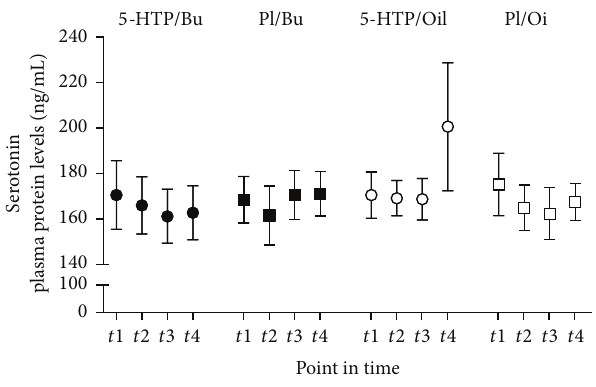
Figure 2: Serotonin plasma levels. The influence of 5-hydrox- ytryptophan (5-HTP) and fatty acid ingestion on serotonin plasma concentrations. Participants received a capsule with either 5-HTP or placebo (Pl). They also ingested a standard breakfast supplemented with100 𝜇 L 13 Coctanoidacidandeitherbutter(Bu)oroliveoil(Oil). Plasma samples were taken during fasting (t1) and after 5-HTP or placebo intake after 2.5 hrs (t2), 4hrs (t3), and 5.5 hrs (t4). The actual plasma concentrations of serotonin protein are presented as means ± SE. Statistics: serotonin; no statistical